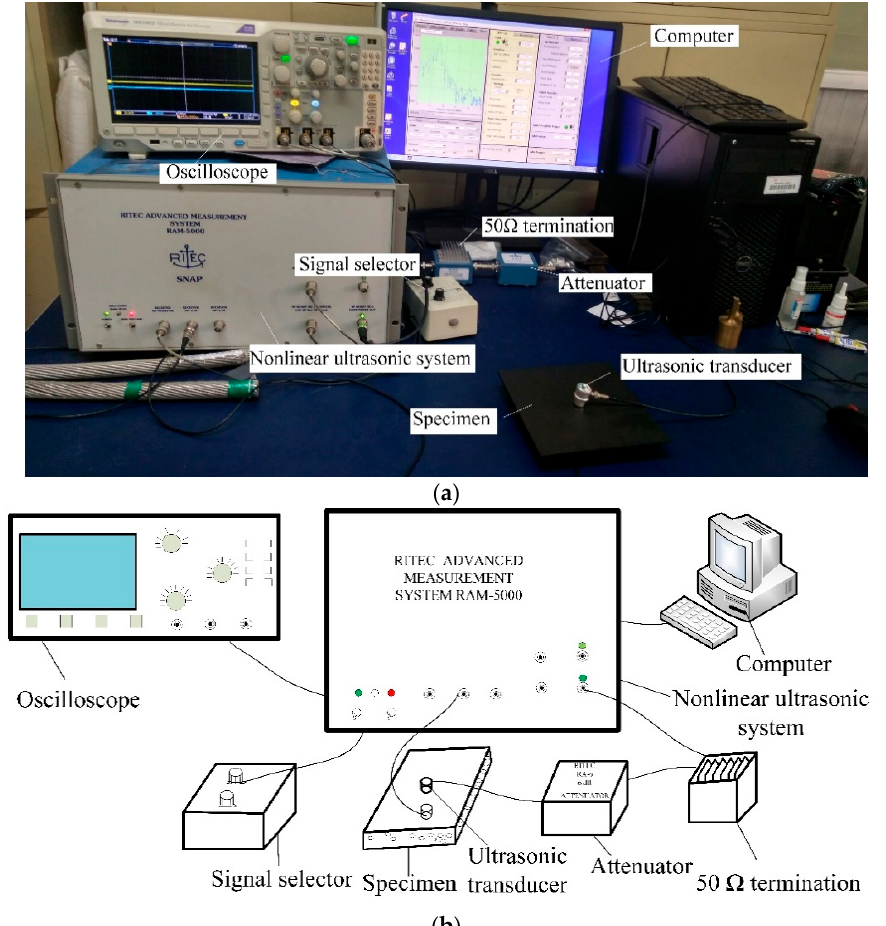
Figure 3. Experimental system: ( a ) physical map, and ( b ) schematic diagram.